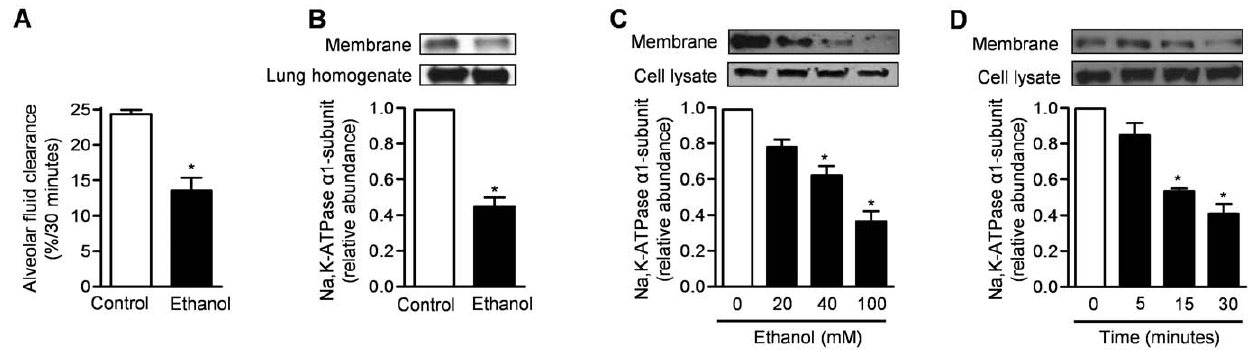
Figure 2. Alcohol decreases the rate of alveolar fluid clearance and downregulates Na,K-ATPase invivo and invitro . Mice were treated with ethanol (20%, 4 g/kg i.p.) or control vehicle (sterile w) daily for 5 days and ( A ) alveolar fluid clearance was measured and ( B ) basolateral membrane (BLM) abundance of a 1 -subunit of the Na,K-ATPase in peripheral lung tissue was evaluated via immunoblotting 4 hours after the last dose. N=7 mice/group for alveolar fluid clearance measurements and N=3 for evaluation of Na,K-ATPase, *p , 0.05 between alcohol and control vehicle. ( C, D ) Plasma membrane abundance of the a 1 -subunit of the Na,K-ATPase in primary rat AEC was evaluated via immunoblotting ( C ) 30 minutes after treatment with different doses of ethanol and ( D ) for up to 30 minutes after treatment with high dose ethanol (100mM). N $ 3 for all measures, *p , 0.05 for comparison with untreated cells.